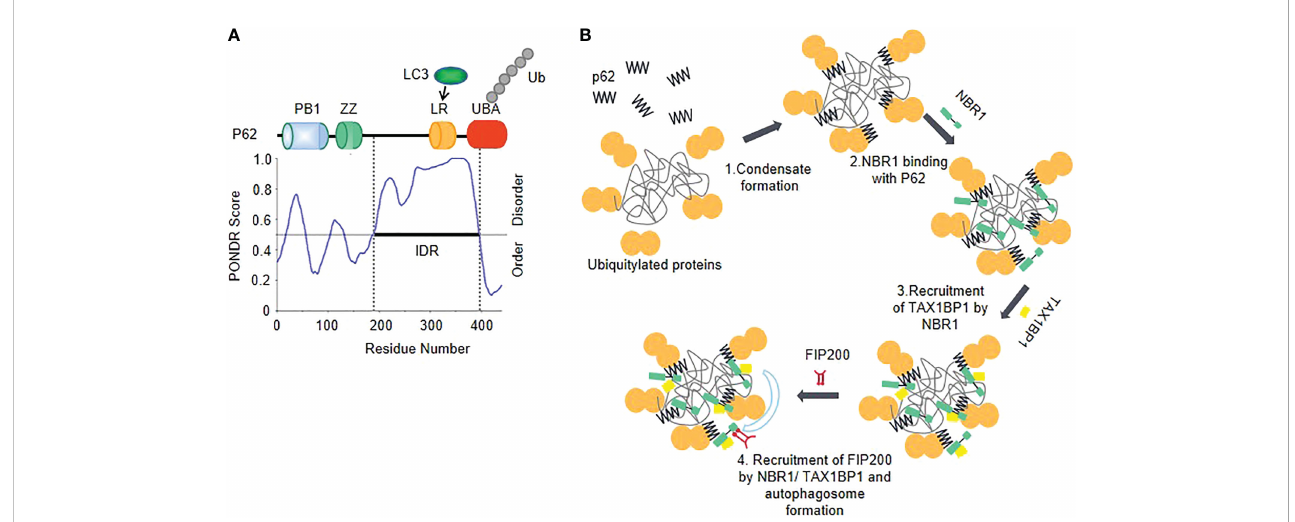
FIGURE 4 Phase separation of autophagy factors balances in fl ammation (A) The schematic of the domain structure and the intrinsic disorder pro fi le of P62 obtained from PONDR are shown. (B) Model of cargo receptors ’ interplay in autophagy initiation. Oligomerized p62 and polyubiquitin chains interact with each other to trigger their phase separation and start forming p62 bodies. TAX1BP1 is recruited by NBR-1 which promotes p62 phase separation and initiates FIP200